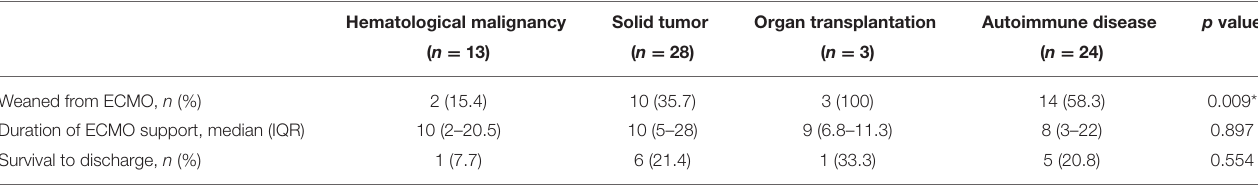
TABLE 3 | Outcomes for specific immunocompromised status and specific causes of ARDS. Hematological malignancy Solid tumor Organ transplantation Autoimmune disease p value